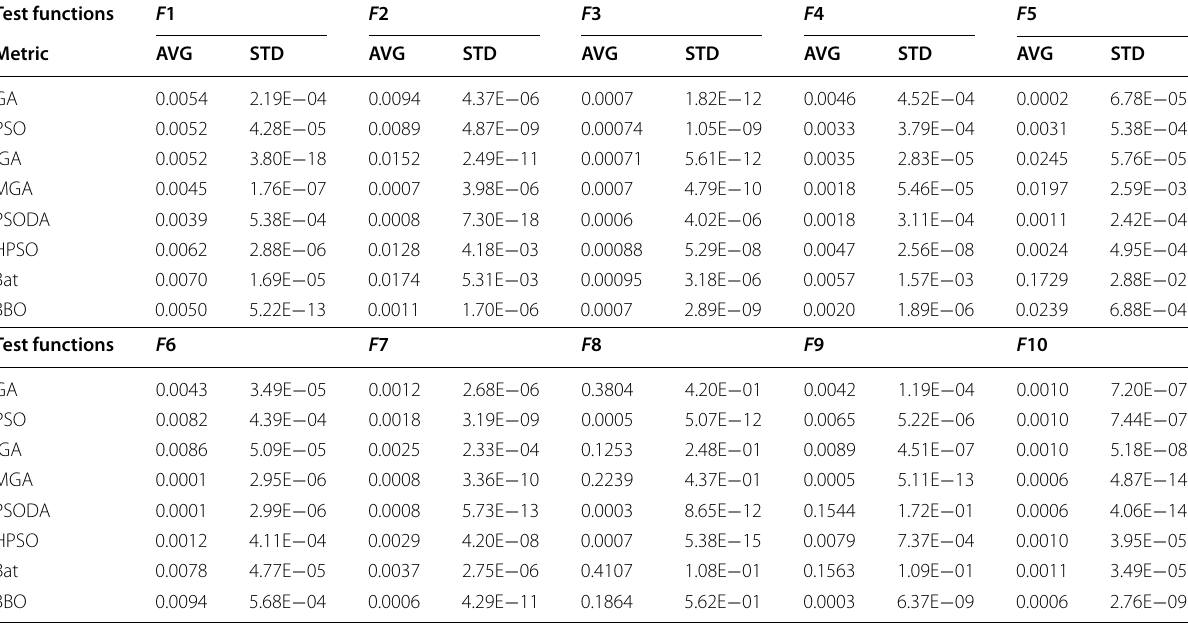
Table 4 Average and standard deviation of (cid:31) x obtained by the different